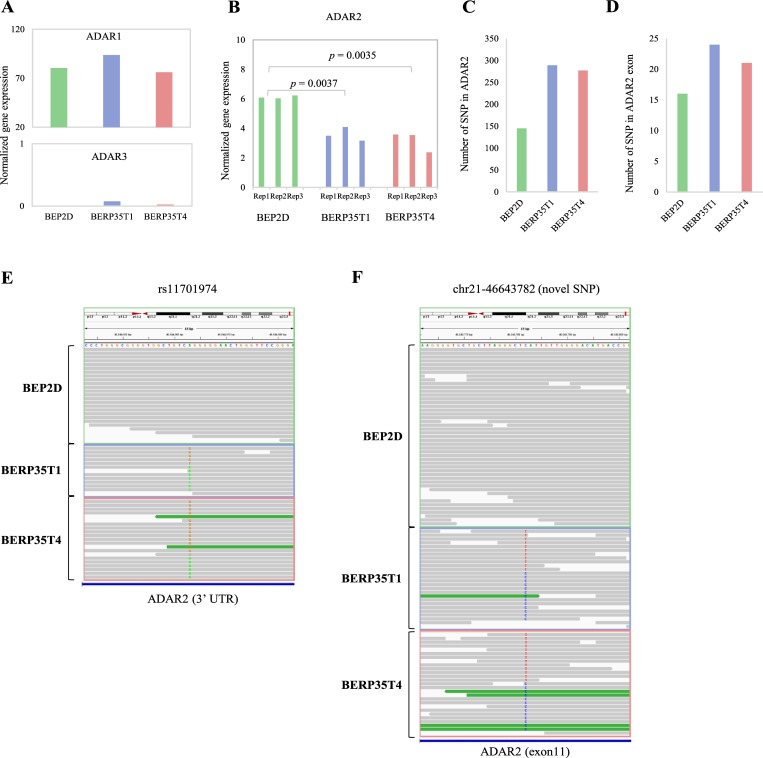
Down-regulation of ADAR2 induce RNA editing.A, B. Bar plots showing the normalized gene expression of ADAR1, ADAR2 and ADAR3 in each cell line. C, D. Bar plots showing the number of genomic variants in ADAR2 (C) and exons of ADAR2 (D). E, F. IGV plots showing the sequencing reads information of mutation rs11701974 and novel mutation chr21:46643782.